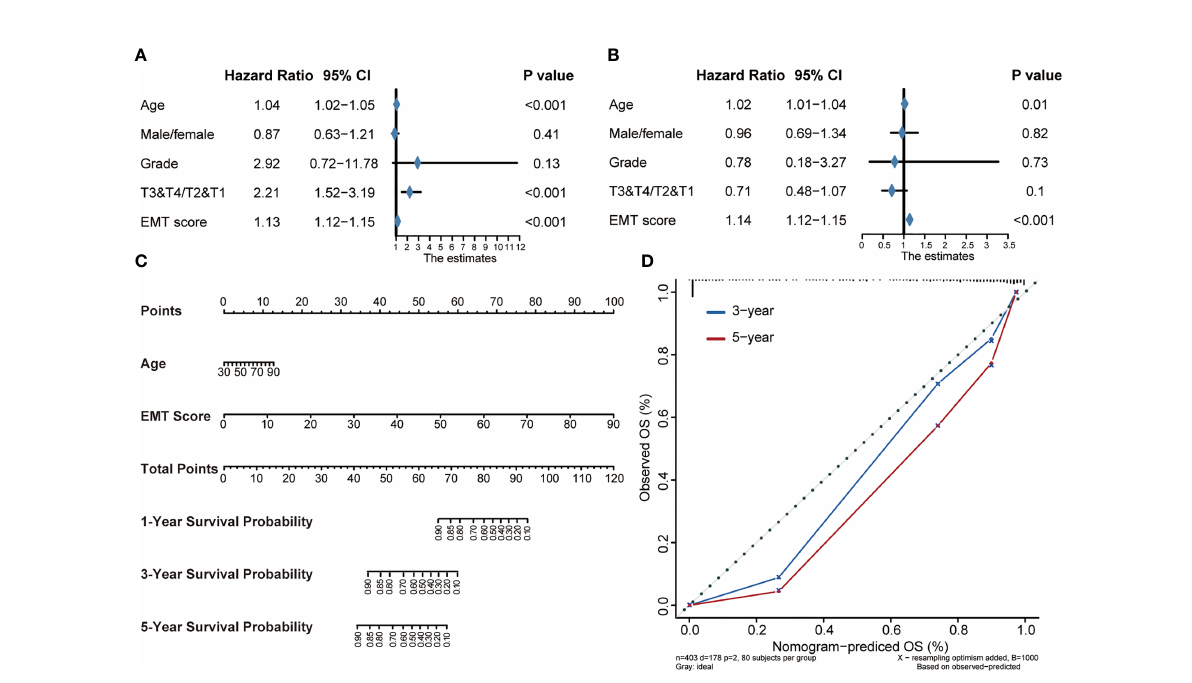
FIGURE 4 Construction of a Nomogram by integrating the EMT risk score and clinicopathological features in TCGA-BLCA cohort. (A, B) Forest plots of univariate and multivariate Cox analysis of TNF-based risk score combined with age, gender, tumor grade and stage of BLCA. (C) Nomogram developed by using age and EMT risk score. (D) Calibration curves of the